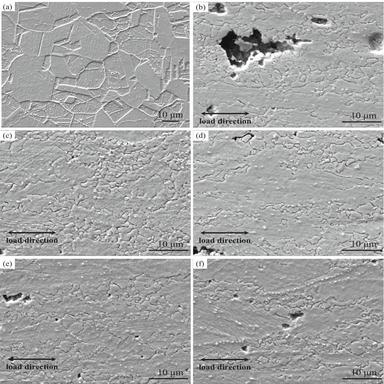
SEM/LEI images of the (a) as-received IN600 (AR) and crept samples at 675 ◦C at approximately 0.5 mm below the fracture surface of the IN600 alloy for stress levels of (b) 150, (c) 157.5, (d) 165, (e) 180, and (f) 210 MPa.